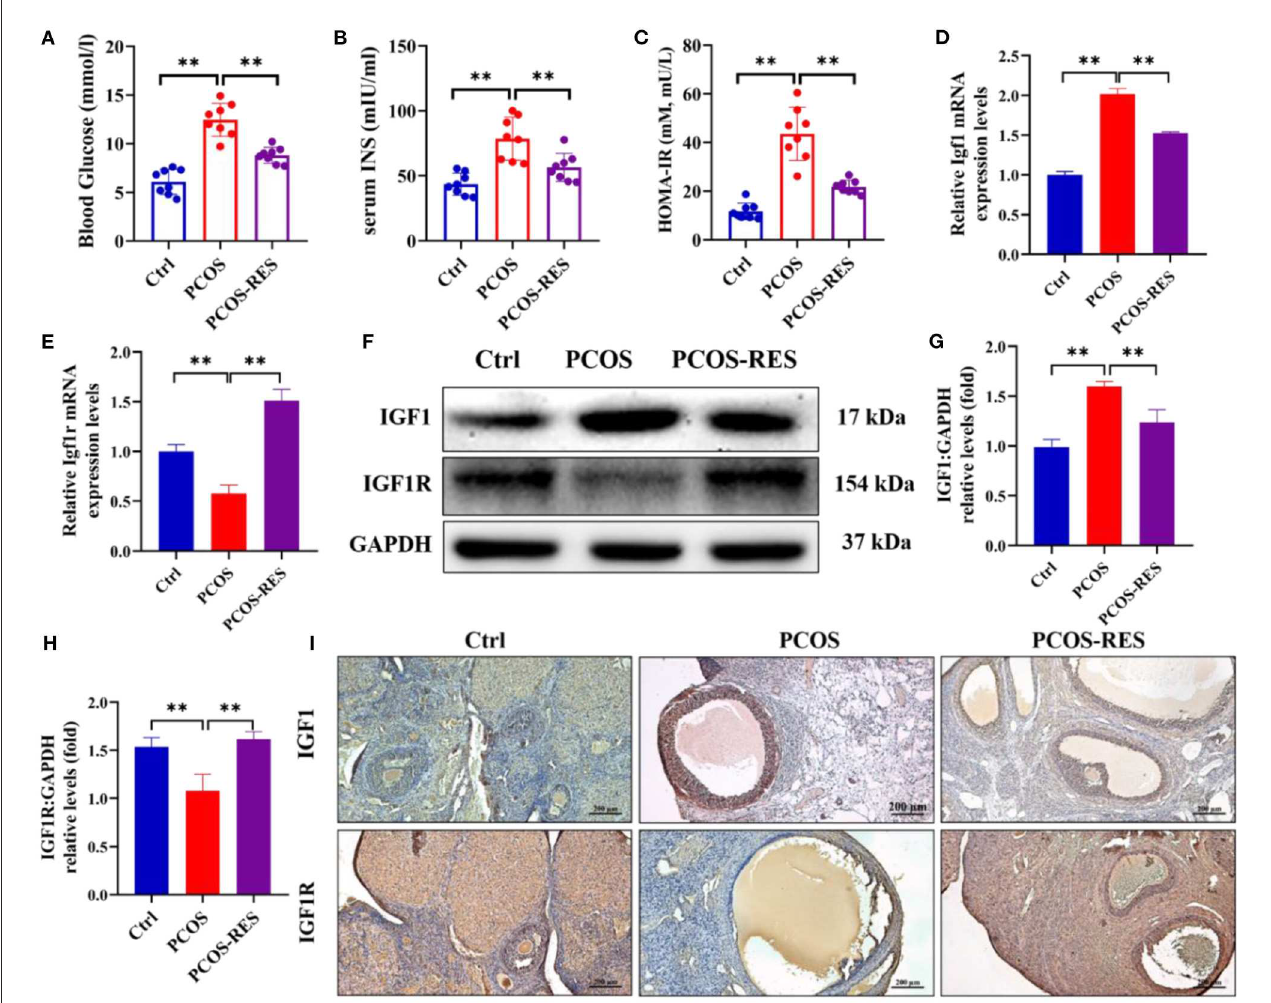
FIGURE1 Resveratrol can enhance the ovarian insulin sensitivity in PCOS rats. The level of blood glucose (A) , serum insulin (B) , and HOMA-IR (C) was shown ( n = 8). The relative mRNA expression levels of IGF1 (D) and IGF1R (E) in the ovary were determined using qPCR. The protein levels of IGF1 and IGF1R were determined by Western blot (F) and quantified by Image J software [IGF1 (G) and IGF1R (H) ]. Immunohistochemistry analysis of the expression of IGF1 and IGF1R (I) . Significant differences between the groups are shown as ** P <